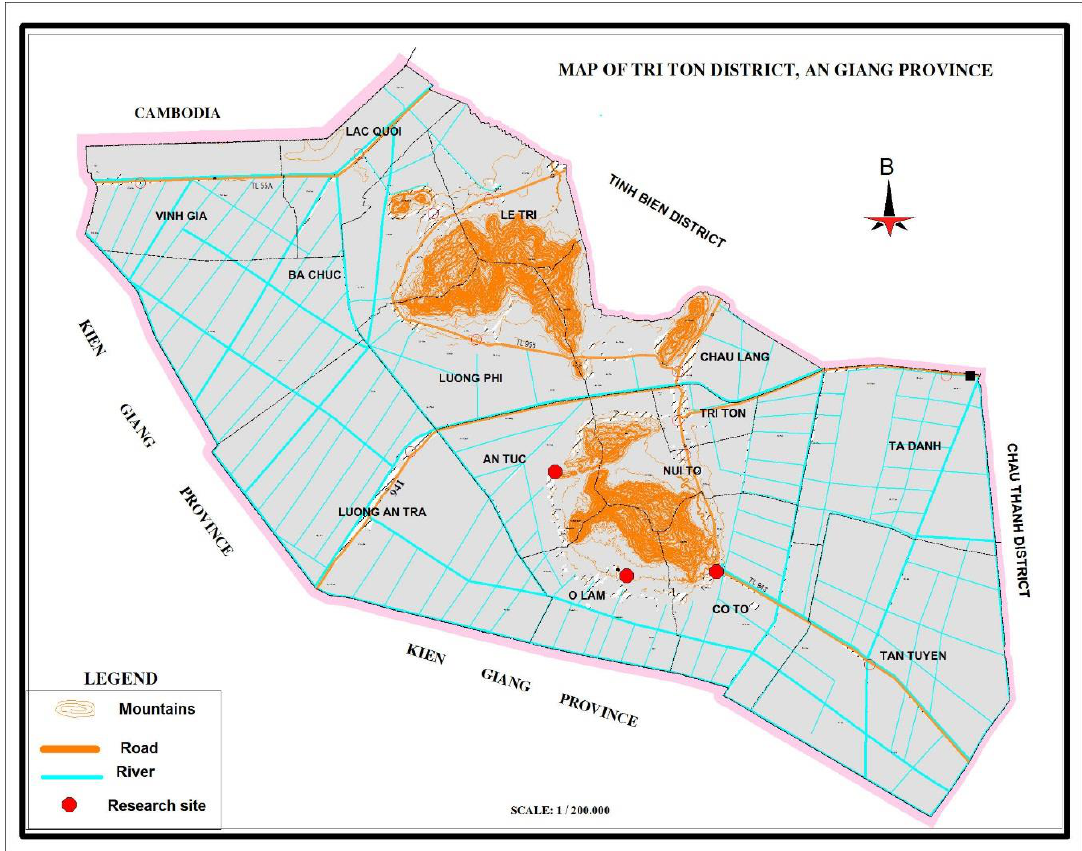
Figure 1. Map of Tri Ton district, An Giang province (Reprinted/adapted with permission from Ref. [42]. Copyright 2020, Tien Duy